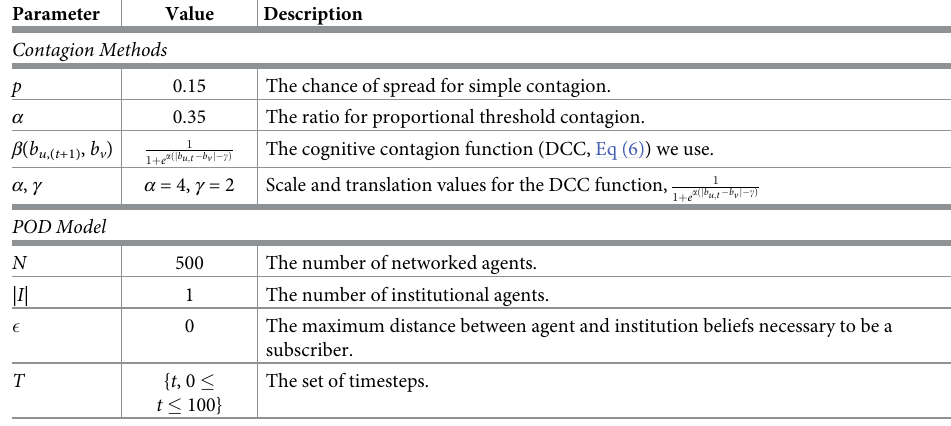
Table 1. Parameter values for in-silico contagion experiments. Parameter